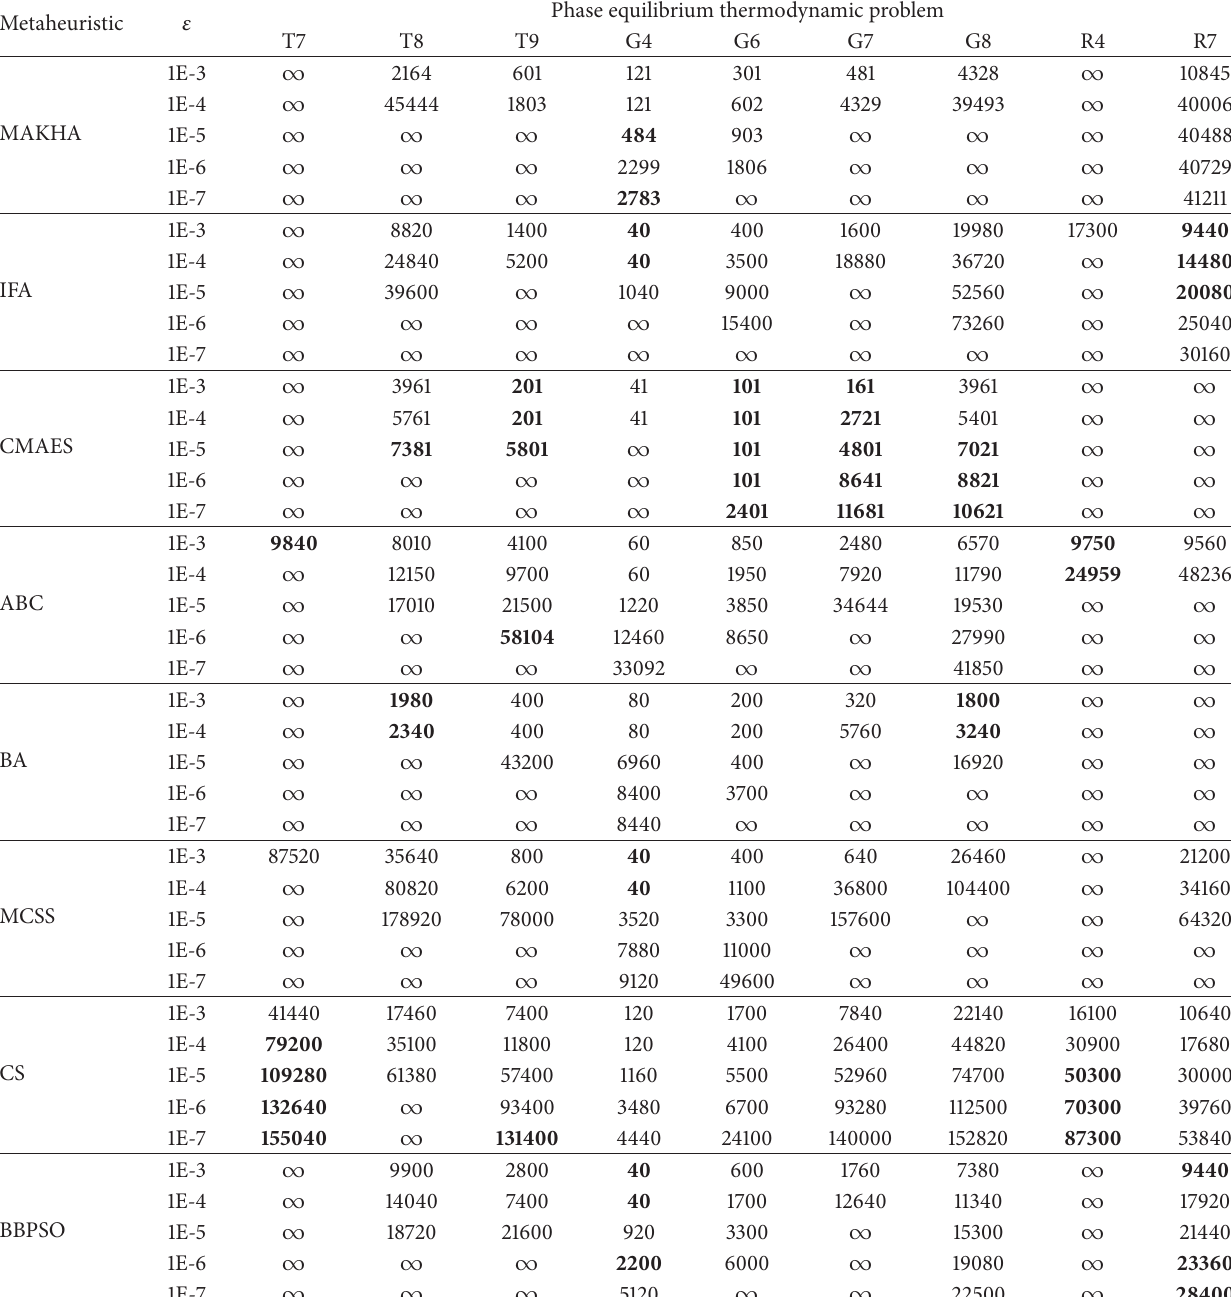
Table 4: Minimum NFE for the average best value to reach 1E-3, 1E-4, 1E-5, 1E-6, and 1E-7 from the known global minimum. Metaheuristic 𝜀